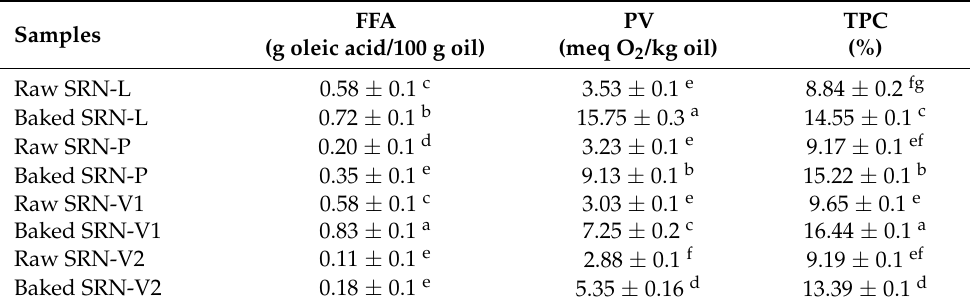
Table 4. Free fatty acids (FFA), peroxide values (PV), and total polar compounds (TPC) of the SRNs produced with the different fat blends, L, P, V1 and V2.